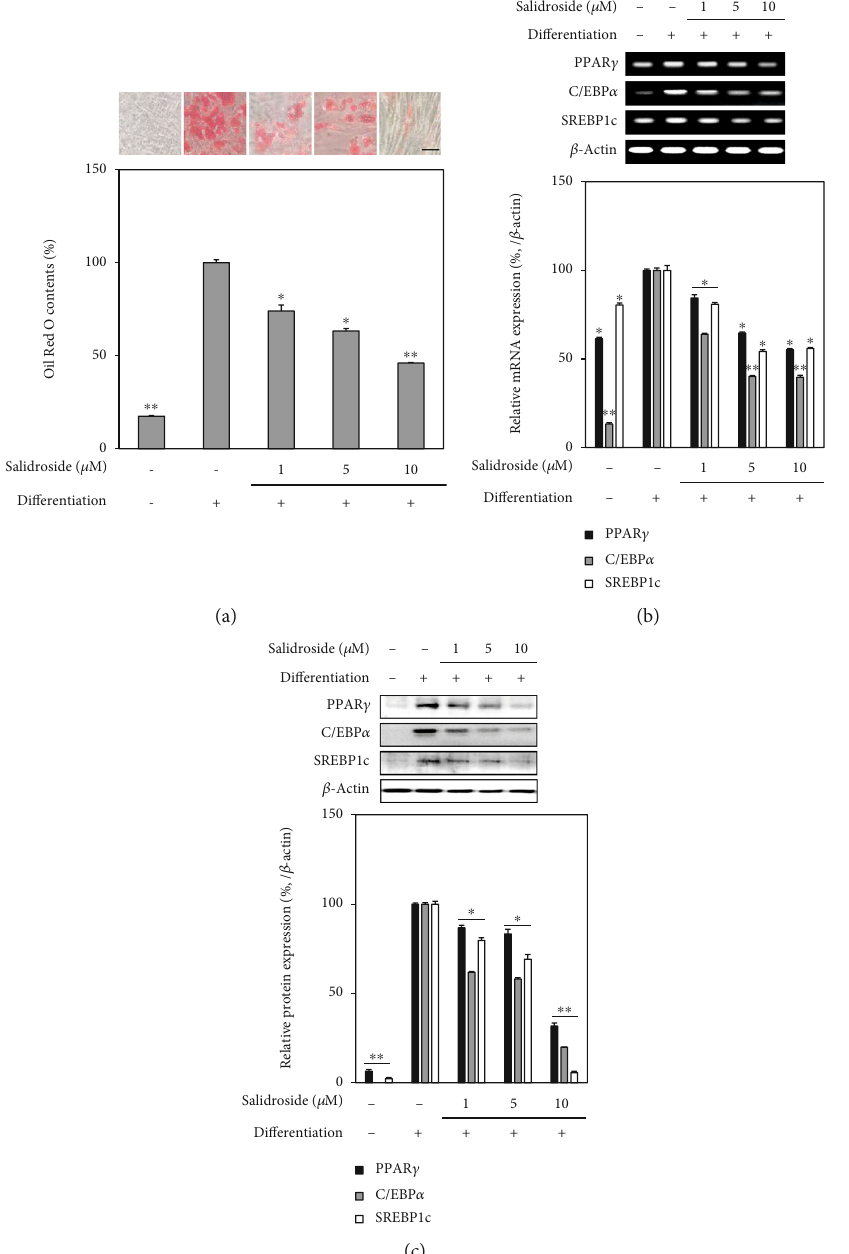
Figure 8: E ff ect of salidroside on the adipogenic di ff erentiation of hBM-MSCs. (a) Adipo-induced hBM-MSCs in 6-well plates without or with salidroside treatment (1, 5, and 10 μ M) were stained with Oil Red O at day 14 of di ff erentiation. Images of cells show stained lipid droplets (upper panel). Lipid accumulation levels were calculated by the colorimetric quanti fi cation of the dye removed from the wells (lower panel) and given as percentage of the untreated di ff erentiated control group. Analysis of (b) mRNA and (c) protein levels was carried out by RT-PCR and Western blotting, respectively, using the adipo-induced hBM-MSC lysates at day 14 of di ff erentiation. PCR and protein bands were densitometrically quanti fi ed and plotted as relative percentage of the untreated di ff erentiated control group. β - Actin was used as internal loading control. ∗ p < 0 : 05 and ∗∗ p < 0 : 01 vs. the untreated di ff erentiated control group. Scale bar: 50 μ